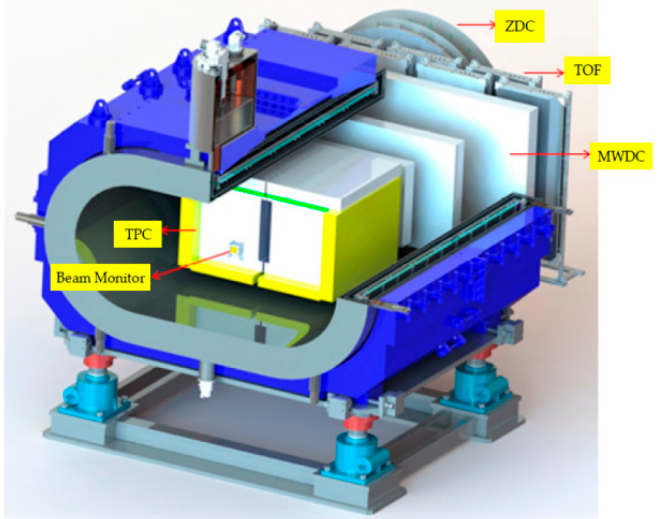
Figure 1. Primary detectors of the CEE [6].